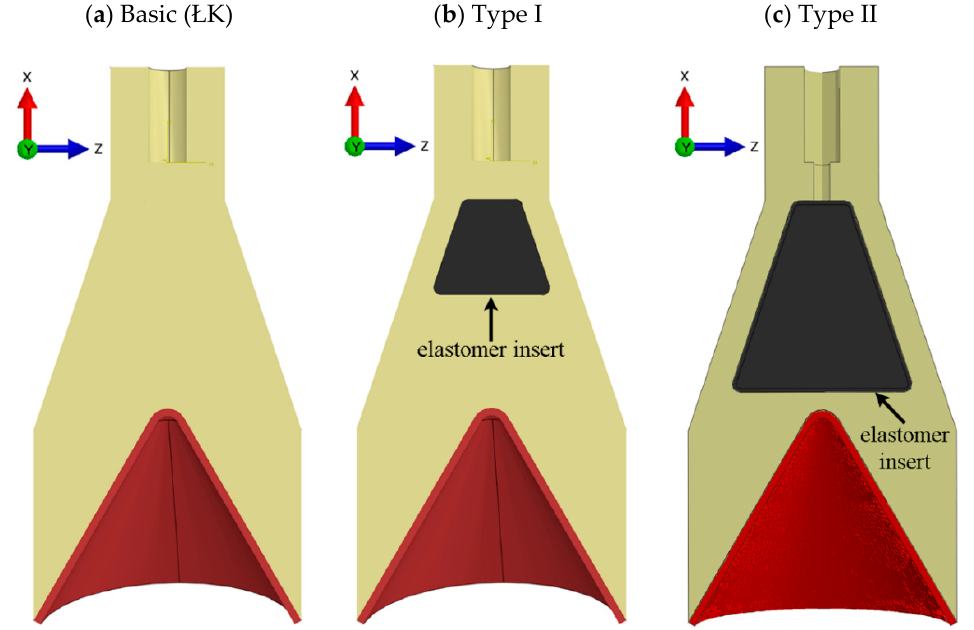
Figure 10. Models for the simulation analysis of the ŁK charge.